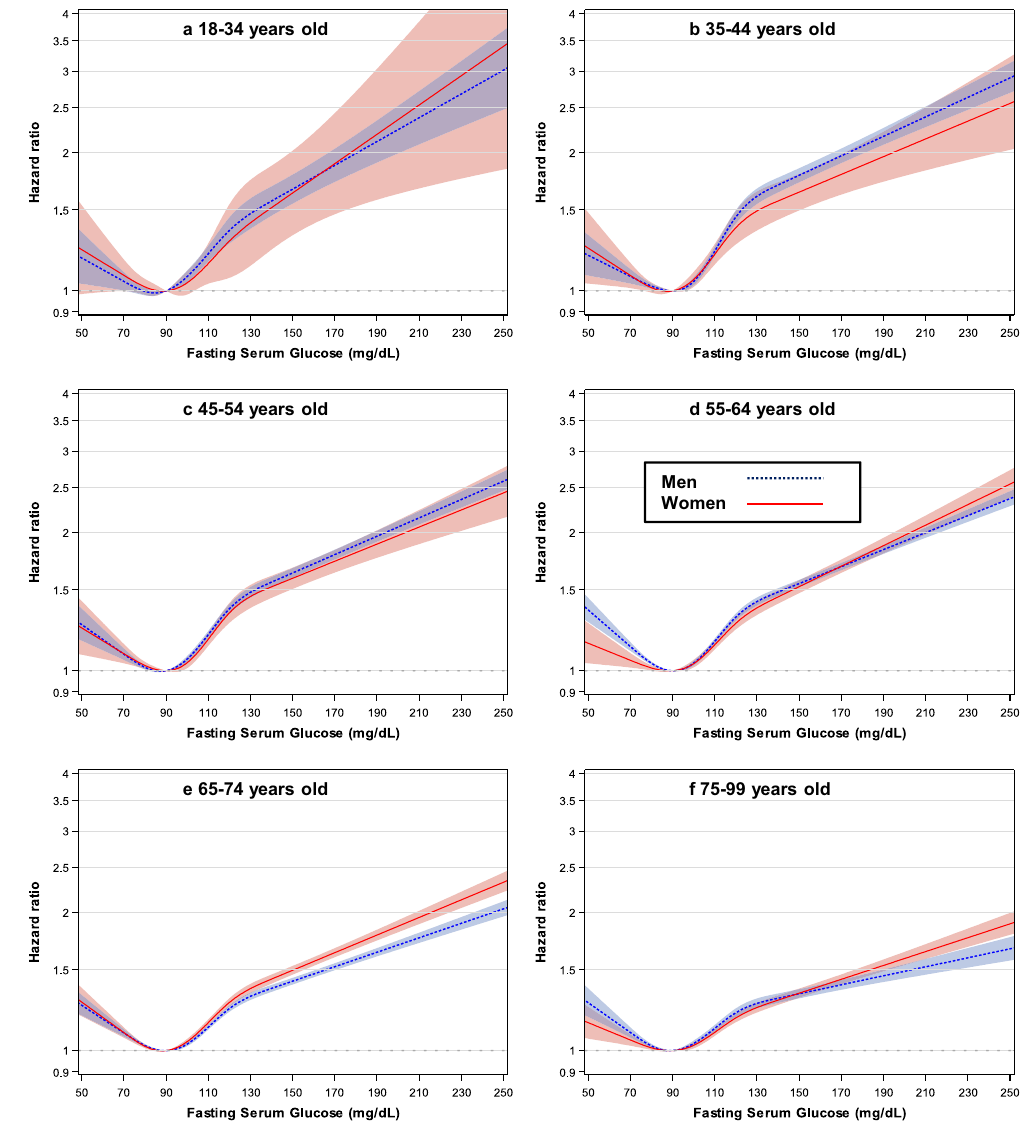
Figure 3. Hazard ratios * for mortality according to age by restricted cubic splines of fasting serum glucose with five knots (70, 85, 100, 120, and 140 mg/dL) and 90 mg/dL as a reference in men (n = 7,043,405) and women (n = 5,356,918) having fasting glucose ≤ 300 mg/dL. * Hazard ratios and 95% confidence intervals were calculated using the same method as in Fig. 2. To convert glucose from mg/dL to mmol/L, multiply by